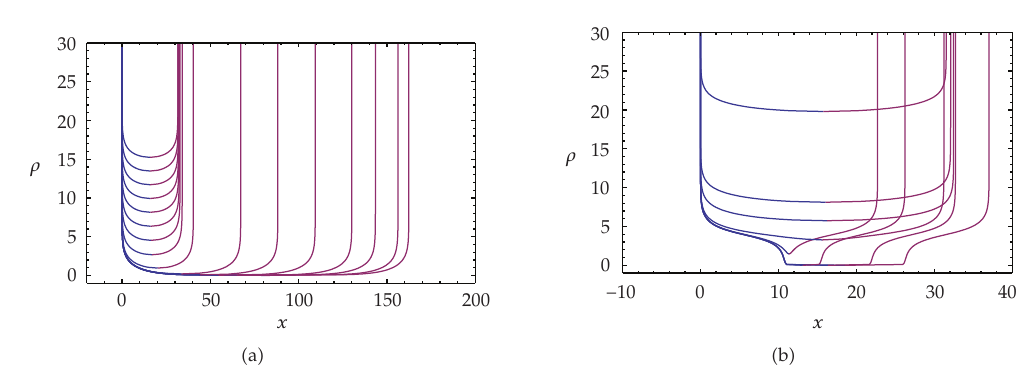
Figure 15: The strings in (cid:5) x,ρ (cid:6) -plane, obtained with various choices of C 2 > f 2 (cid:5) 0 (cid:6) . Left to right, the background is described by the numerical solutions in Figure 9, characterized by increasing values of ρ ∗ (cid:8) 0 and ρ ∗ (cid:9) 4, respectively. All calculations performed with ρ 1 (cid:8) 30, and other units set as explained in the text (cid:3) 58 (cid:4) .